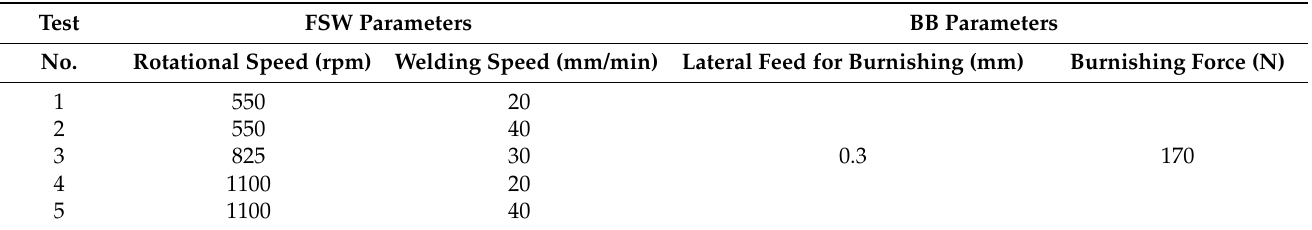
Table 2. Design of experiments for aluminum alloy AA2024-T3 workpieces .